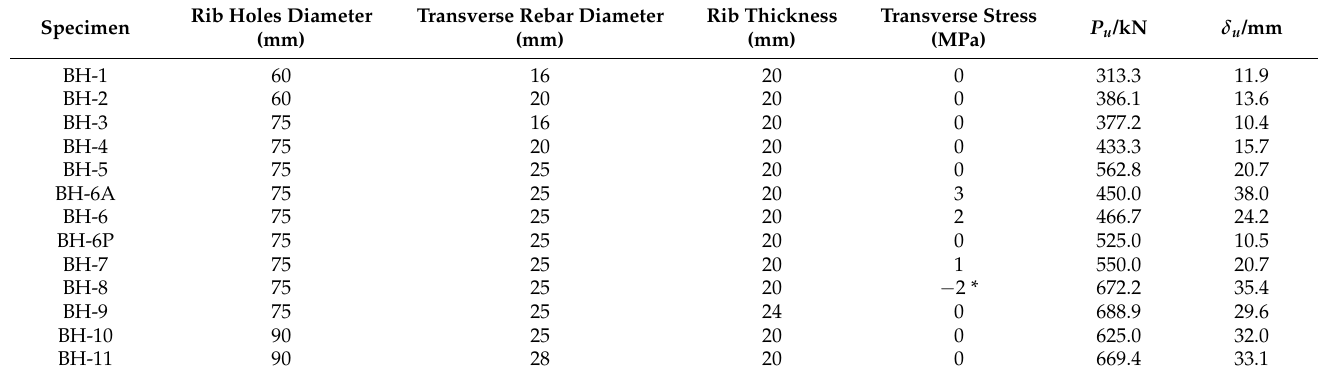
Figure 5. Steel structure.